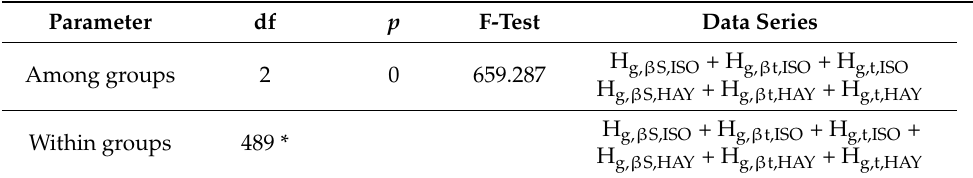
Table 4. Fisher–Snedecor (F-test) statistic applied to the H g,ISO and the H g,HAY data series for Saudi Arabia in the period 2005–2016 under the 3 solar system configuration modes in all-sky conditions. df = degrees of freedom, p = probability, N = population size of each individual data series. The confidence interval is 95% ( α =